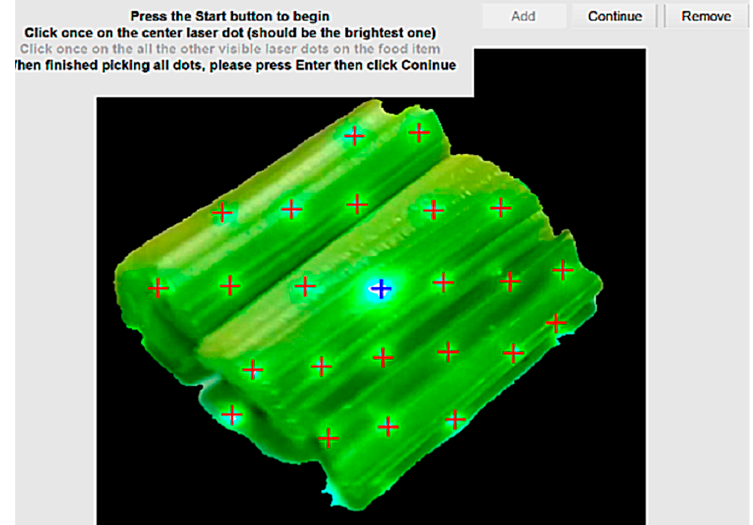
Figure 12. The last step, the manual dot selection GUI (which, in this case, shows a photograph of celery), corrects the automation algorithm’s errors. The picture shows a bunch of celery which has been manually traced for each laser dot to address the limitation of the algorithm in detecting green laser dots on green objects.